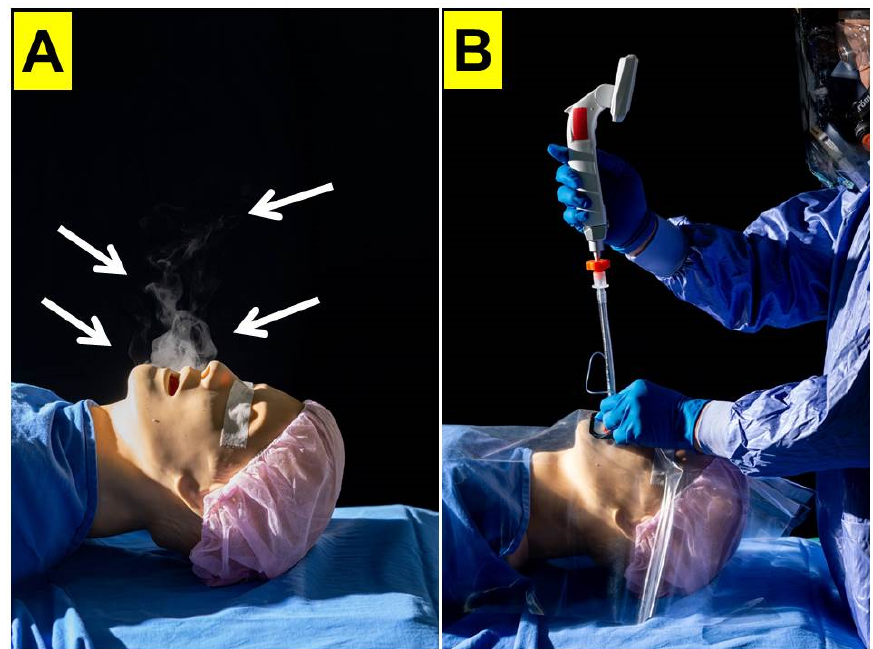
Figure 12. Protection from aerosol spreading contamination by video-assisted intubating stylet technique and a piece of plastic sheet barrier demonstrated in a mannequin. ( A ) Arrows in white color demarcate the area of simulated aerosol spreading; ( B ) with the coverage of a piece of plastic sheet as barrier during stylet intubation procedure, there was no aerosols detected which continuously spread under the plastic coverage.